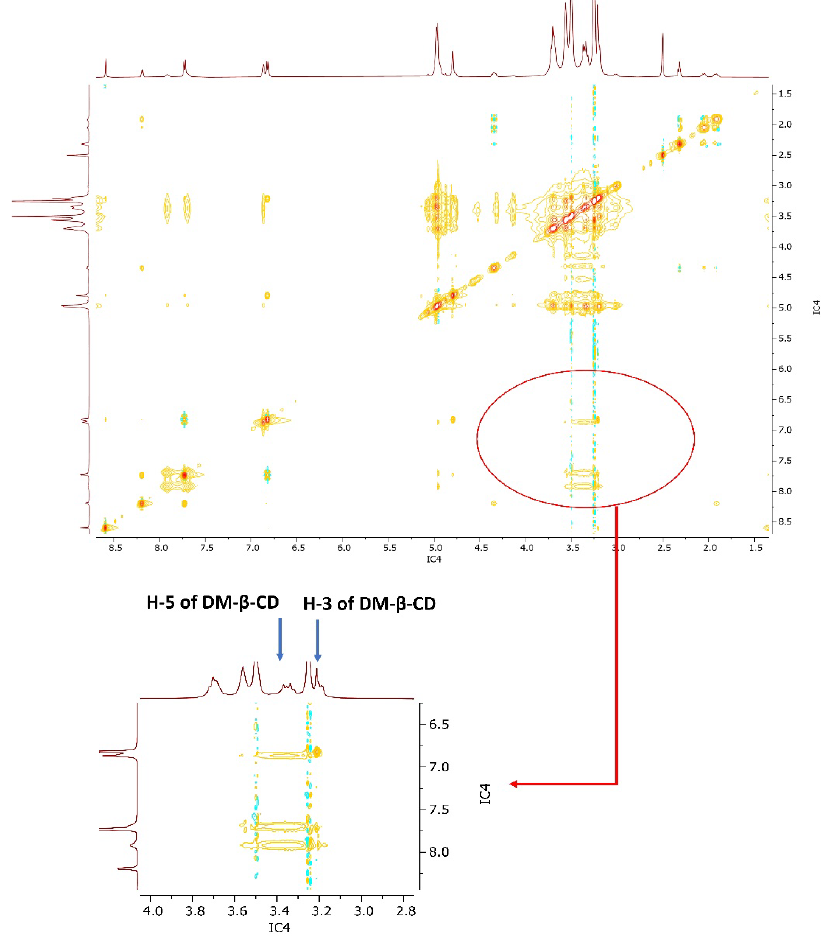
Figure 8. Two-dimensional (2D) NOESY spectrum of MTX/DM- β -CD inclusion complex (IC4) in DMSO. Table 5. Pharmacokinetic parameters of methotrexate (MTX)-loaded inclusion compounds; MTX/HP- β -CD inclusion complex (IC1); MTX/ β -CD inclusion complex (IC2); MTX/M- β -CD inclusion